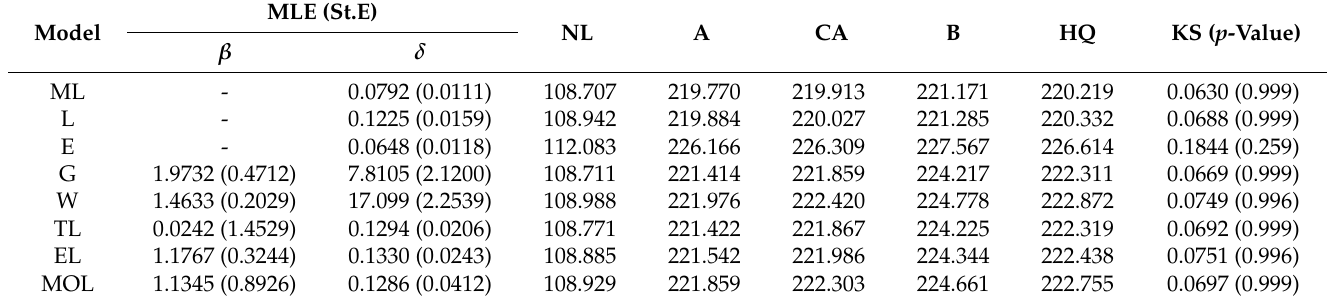
Table 2. Summary of fit of ML and its competitive models from mechanical equipment data.